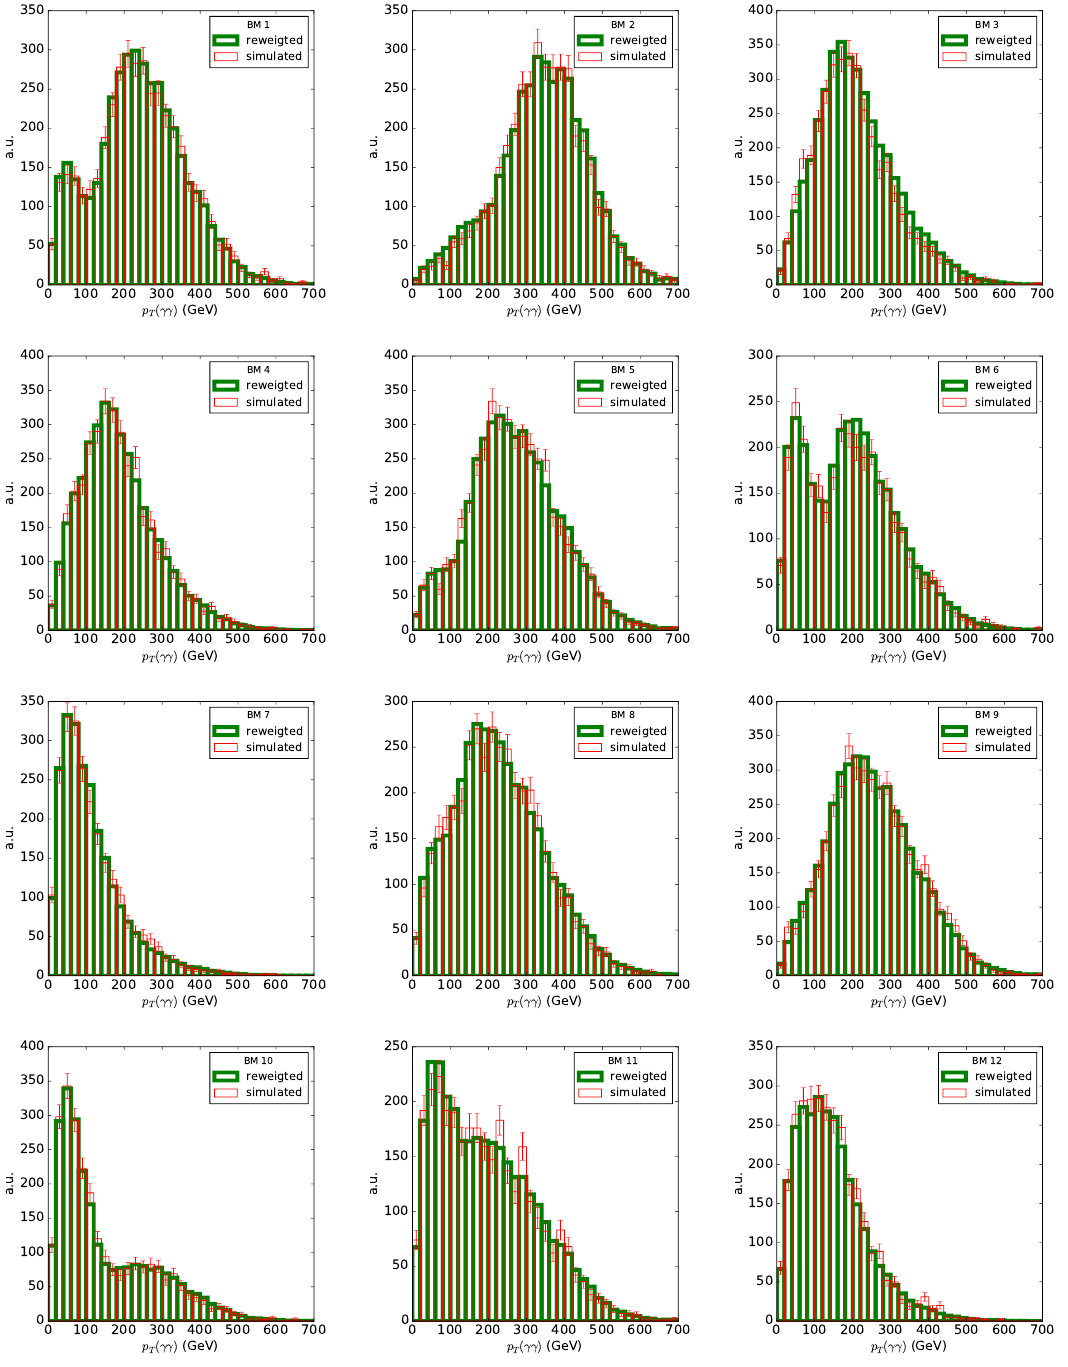
Figure 18 . The reconstructed p T ( γγ ) after ATLAS-like selection. The histograms are normalized by signal efficiency times 100,000